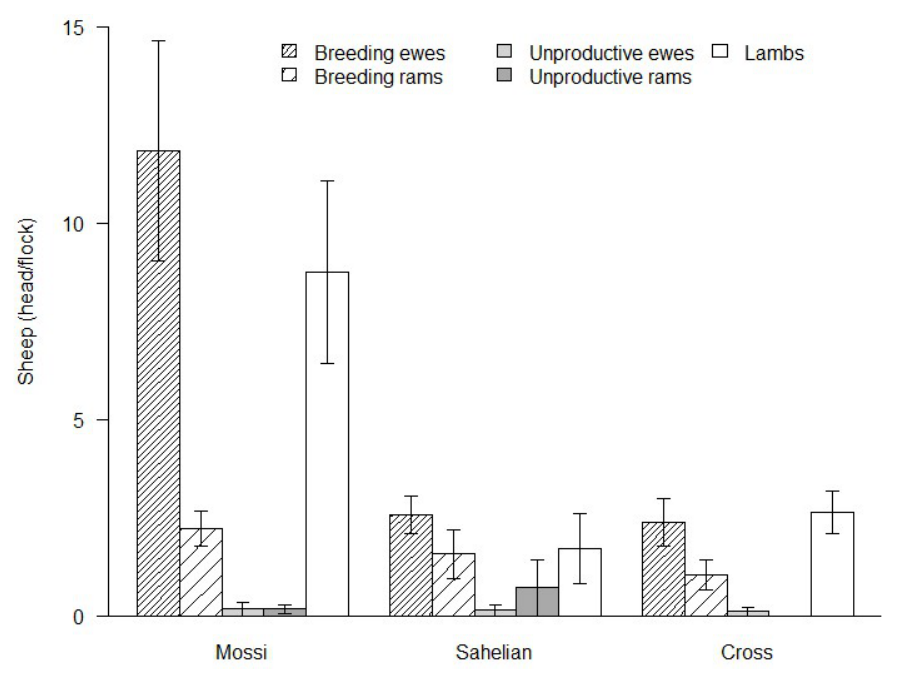
Figure 4. Composition and structure of sheep flocks in Ouagadougou (mean ± standard error); Mossi sheep flocks n = 25, Sahelian sheep flocks n = 9, crossbred sheep flocks n = 19.